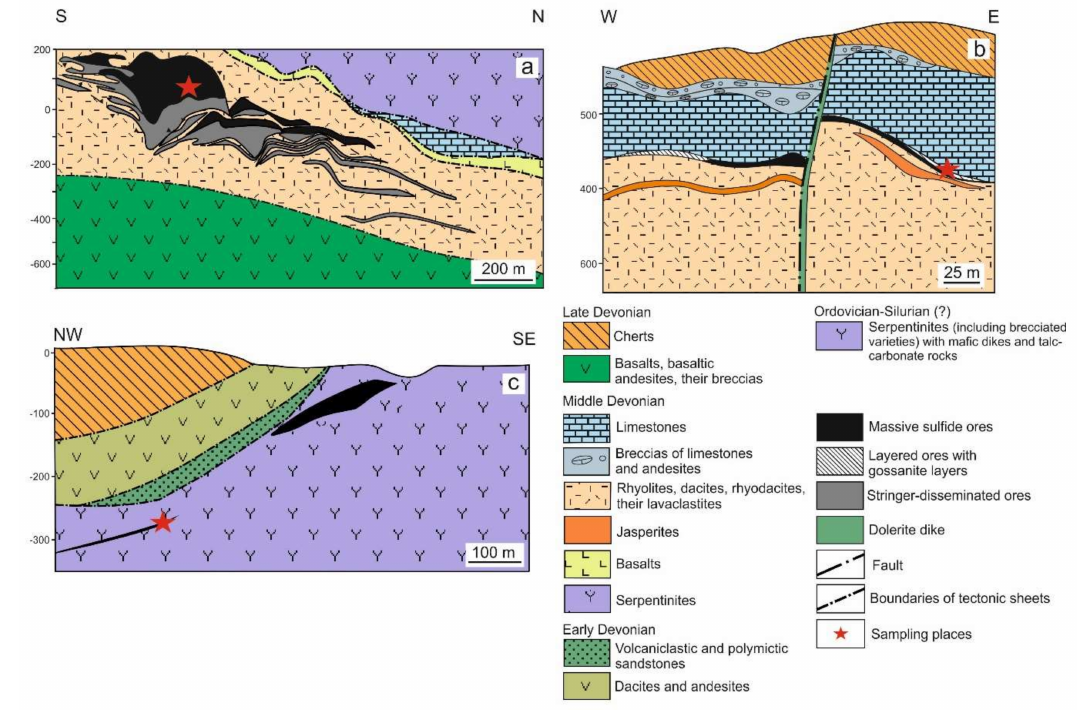
Figure 2. Geological cross-sections of the Saf’yanovskoe ( a ), Talgan ( b ), and Dergamysh ( c ) massive sulfide deposits (simplified from